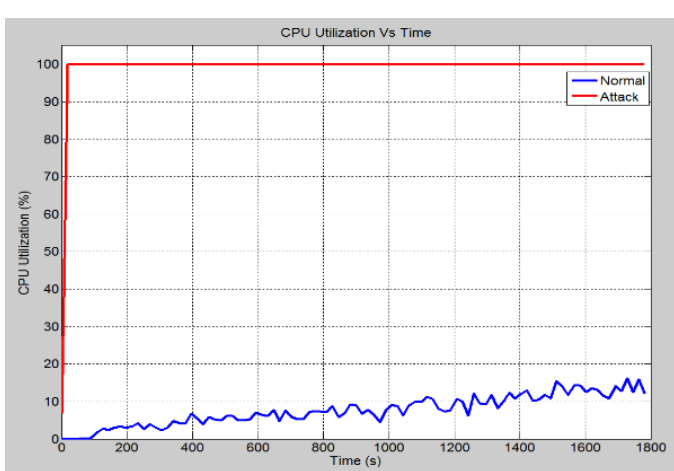
Figure 10. DB queries.